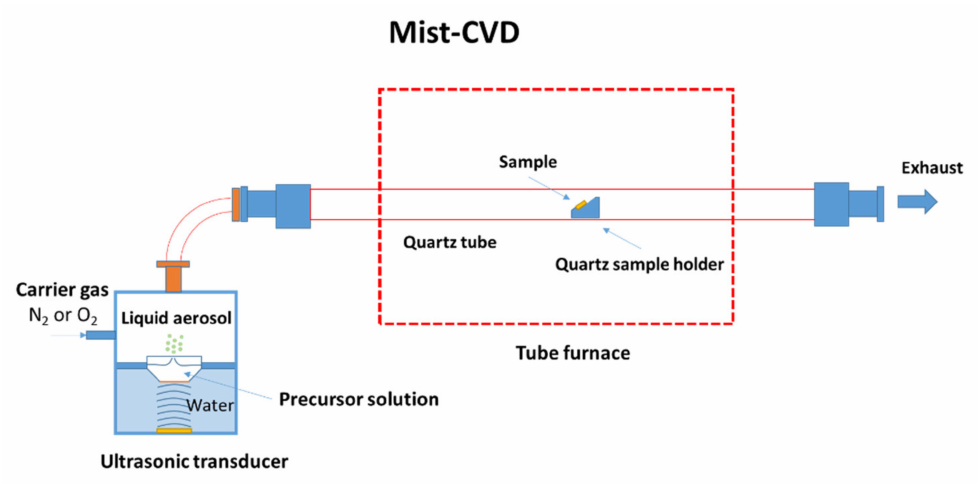
Figure 1. The schematic illustration of Mist-CVD